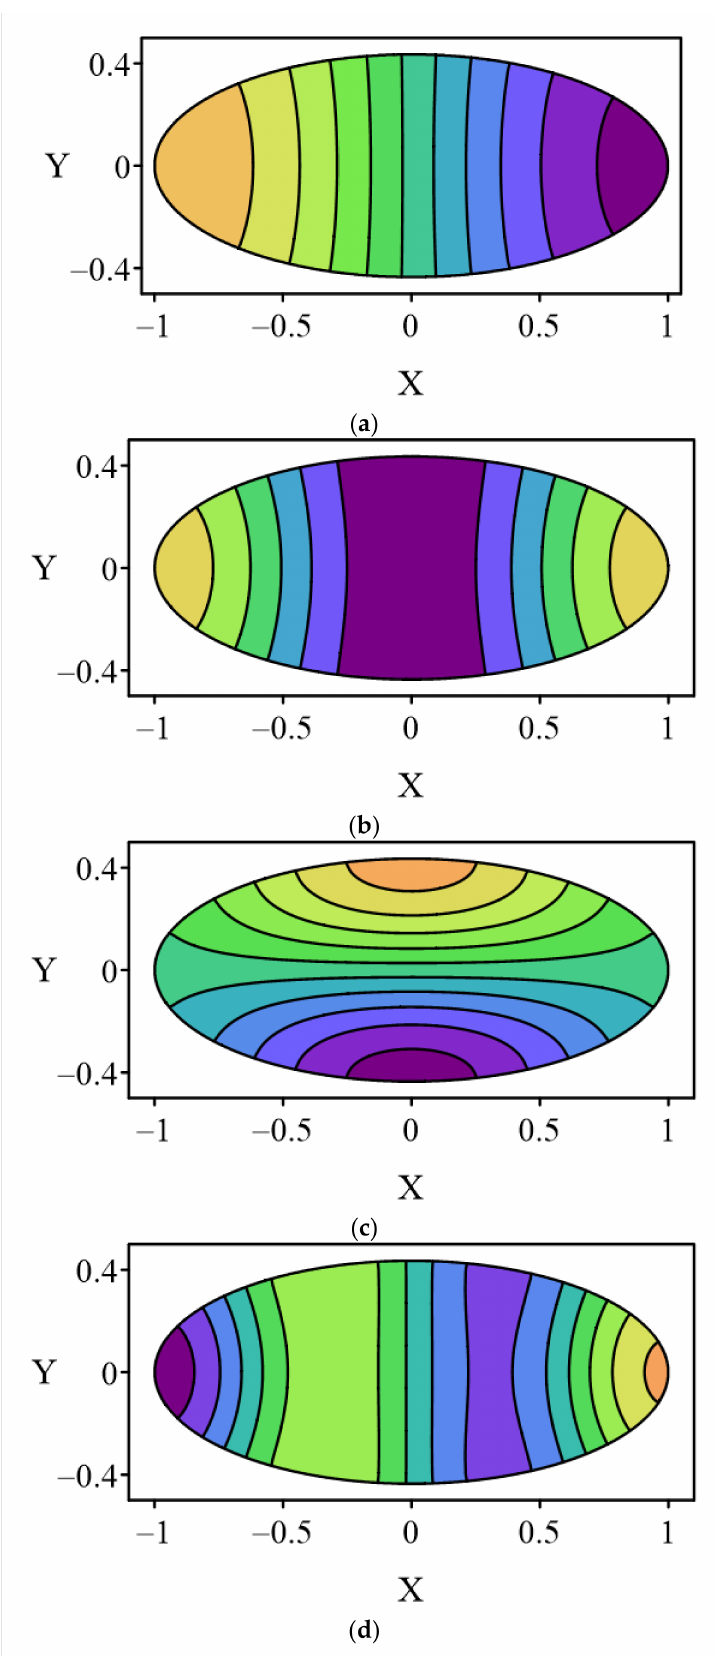
Figure 5. The first four eigenmodes for elliptic waveguide (TE wave): ( a ) k 1 = 1.8766, ( b ) k 2 = 3.4359, ( c ) k 3 = 4.0149, and ( d ) k 4 =